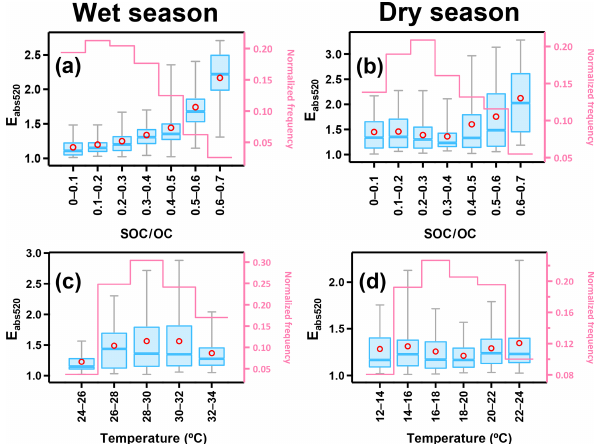
Figure 6. E abs520 dependency on SOC / OC ratio and temperature during wet and dry seasons. Red circles represent the average val- ues. The line inside the box indicates the median. Upper and lower boundaries of the box represent the 75th and the 25th percentiles; the whiskers above and below each box represent the 95th and 5th percentiles. The pink lines represent normalized frequency of data points in each